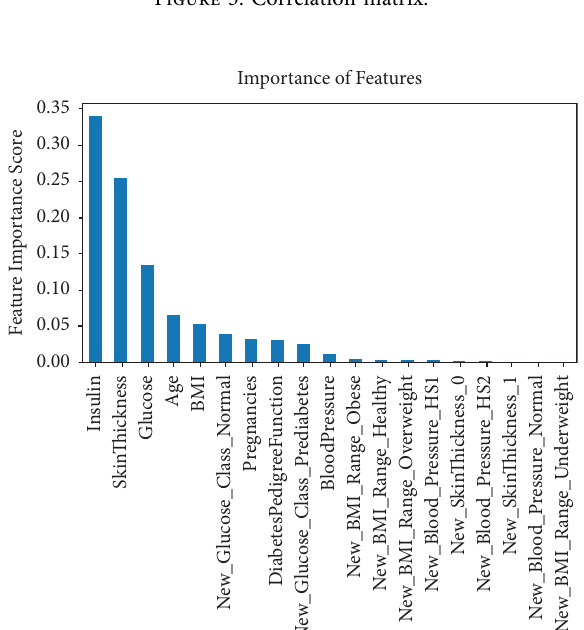
Figure 3: Correlation matrix.